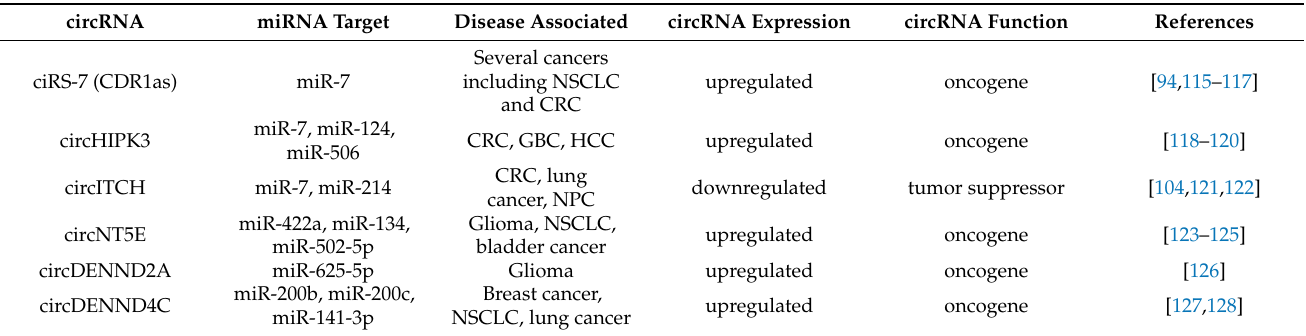
Table 3. Examples of circRNAs acting as miRNA sponges and their functions in various types of